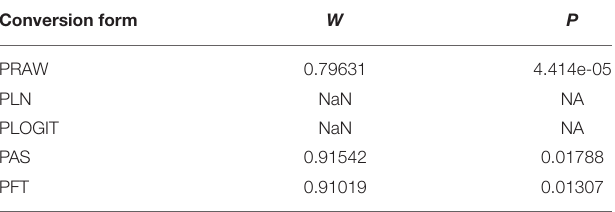
TABLE 2 | Normal distribution test and conversion forms for the normal distribution of prevalence (Immunological methods).